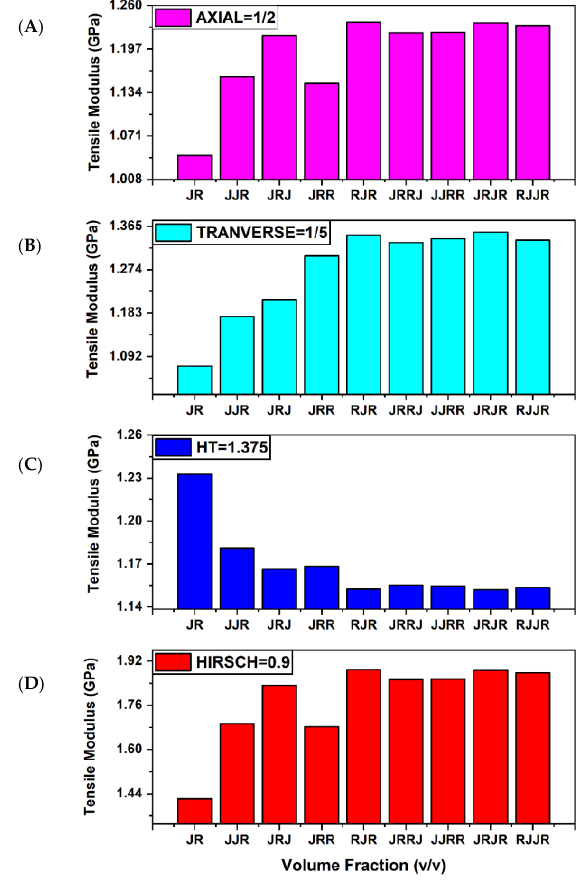
Figure 3. Modulus of composite hybrid: ( A ) ROM = 1/2 ( B ) IROM = 1/5, ( C ) HT = 1.375, ( D ) HI model = 0.9.